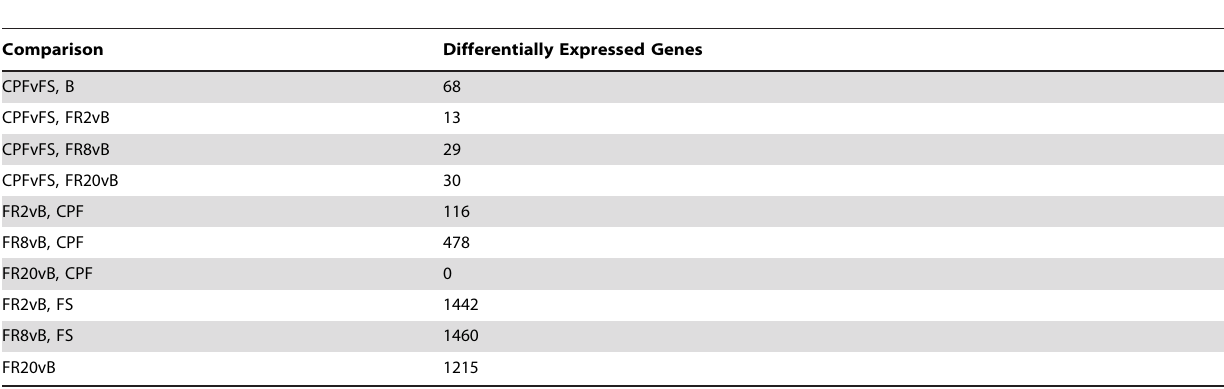
Abbreviations: CPF (Carbohydrate Prefed), FS (Fasted), B (Baseline), FR2, FR8 and FR20 (2, 8 and 20 hours after full resuscitation).